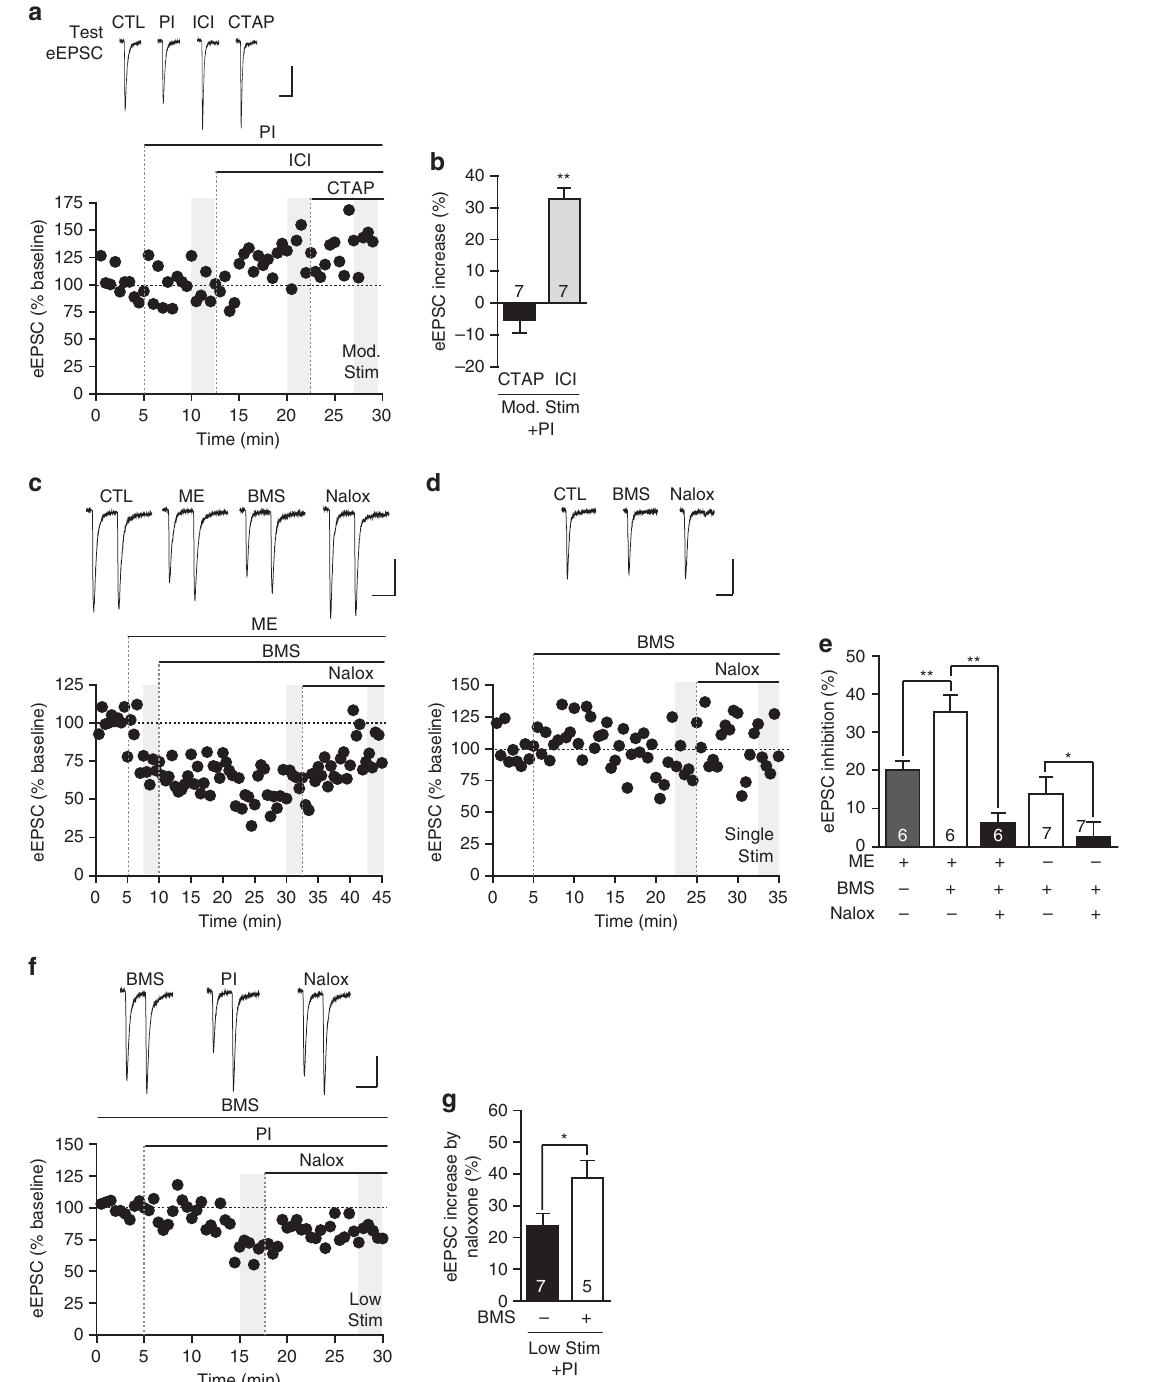
Figure 4 | Endogenously released opioids act exclusively through DOR and their signalling is enhanced by a DOR PAM. ( a , b ) Endogenous opioids signal exclusively through DOR. ( a ) Moderate stimulus ‘test eEPSCs’ and corresponding time plot from single representative experiment. ( b ) Bar chart of percentage increase of eEPSC amplitude by selective antagonists. MOR antagonist CTAP (1 m M) produced no change while DOR antagonist, ICI174864 (ICI, 1 m M) significantly increased test eEPSC amplitude (** P o 0.01, paired t -test, versus PI). ( c – e ) The DOR PAM BMS-986187 (BMS, 1 m M) ( c ) significantly enhanced exogenous ME inhibition (submaximal, 100nM) after at least 15min continuous perfusion and ( d ) decreased single stimulus evoked eEPSC amplitude in absence of exogenous ligand, both were fully reversed by naloxone indicating PAM and not agonist activity of BMS-986187 (see also Supplementary Fig. 1). ( c , d ) Data displaying eEPSCs and time plots of single representative experiment and ( e ) summary bar chart (** P o 0.01, repeated